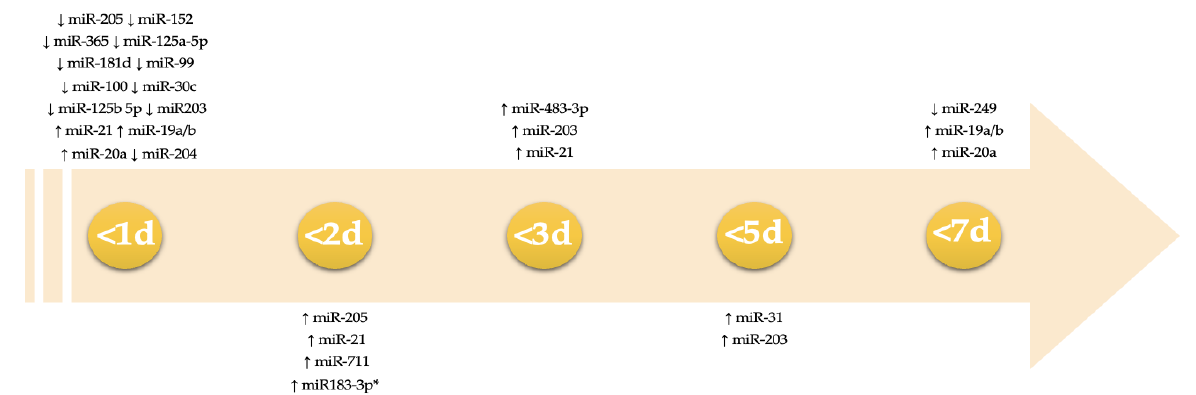
Figure 4. This figure shows the differential expression of miRNA in time (days) after wounding. We included only those miRNAs that showed a variation in expression, according to a precise timeframe. miRNAs variations that occurred within the first 24 h are summarized on the first day. *miR-183–3p shows different expressions in rats and humans; in rats, it was overexpressed within 120 h after wounding, whereas in humans, it was in 48 h. ↑ indicates up-regulation; ↓ down-regula- tion. Table 7. This table summarizes the various miRNAs and their genes and/or proteins target, as stud- ied in the papers included in this review, if available. CCL, chemokine ligand; TGF, transforming growth factor; LepR, leptin receptor; EGR, early growth response; TIMP, metallopeptidase inhibitor; TIAM1, T-cell lymphoma invasion and metastasis inducing protein 1; TP, tumor protein; ITGA, in- tegrin subunit alpha; PI3K, phosphoinositide 3 kinase; AKT, protein kinase B; mTOR, mammalian target of rapamycin; BMP, bone morphogenetic protein; SMAD, small mother against decapenta- plegic; GSK, glycogen synthase kinase; IGR1R, insulin-like growth factor 1 receptor; IL, interleukin, PTPRC, protein tyrosine phosphatase receptor type C; CD, differentiation cluster; SHIP2, SH2-con- taining phosphatidylinositol 3,4,5-trisphosphate 5-phosphatase; RNU6B, RNA U6 small nuclear; MAPK, mitogen-activated protein kinase; NF-kB, nuclear factor kappa-light-chain-enhancer of ac- tivated b cells; TCF-4, transcription factor 4; ID-2, inhibitor DNA-binding 2 protein HLH; VEGFA, vascular endothelial growth factor A; NRCAM, neuronal cell adhesion molecule; C-MET, tyrosine- protein kinase Met; LASP1, LIM and SH3 protein 1; RAN, RAs-related nuclear protein; RAPH1, Ras- associated and pleckstrin homology domains-containing protein 1; ERM, ezrin/radixin/moesin; DDK2, dickkopf-related protein 2; FRAT2, FRAT regulator of Wnt signaling pathway 2; MK2, mi- togen-activated protein kinase-activated protein kinase 2; YAP1, yes-associated protein 1; MKI67, marker of proliferation Ki-67.